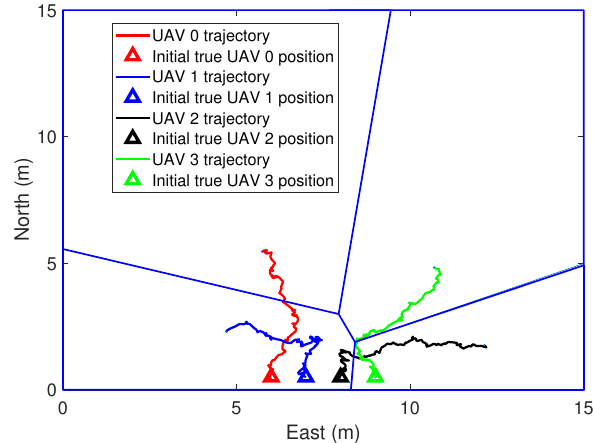
Figure 5. The process of coverage task performing, k = 100